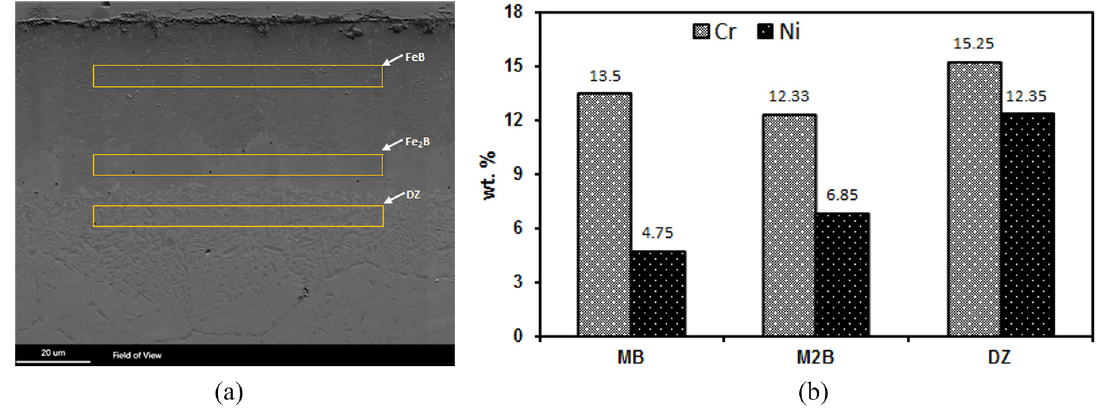
Figure 4. EDS analysis in AISI 304 borided steel at 1223 K for 10 h (a) analyzed areas in cross section (6 × 80 µm), (b) Histogram of composition (wt. %) of Cr and Ni.